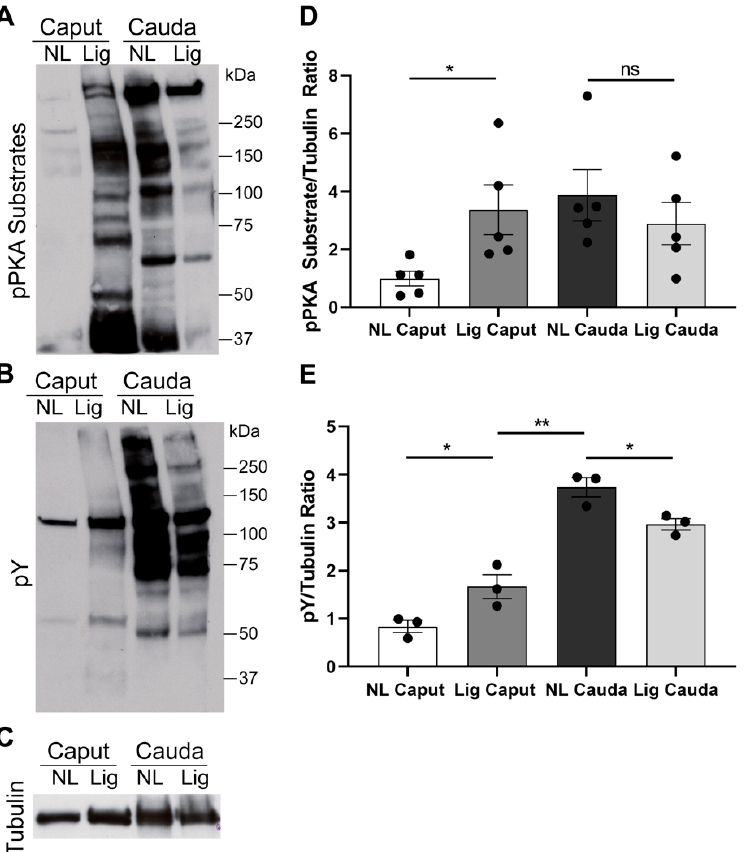
Figure 4. Changes to post-translational modifications in sperm after epididymal ligation. Sperm samples were collected from each experimental region 7-days post-ligation surgery: NL Caput, Lig Caput, NL Cauda, and Lig Cauda. Samples were capacitated for 40 min prior to protein extraction and separation by SDS-PAGE. ( A ) Western blot of phosphorylated protein kinase A substrates (pPKA substrates). n = 5. ( B ) Membranes were stripped and re-probed with an antibody against tyrosine phosphorylation (pY). n = 3. ( C ) Membranes were re-stripped and re-probed with anti β -tubulin antibody to evaluate equal loading. ( D ) Quantification of optical densitometry ratio between pPKA substrates and β -tubulin. n = 5. ( E ) Quantification of optical densitometry ratio between pY and β -tubulin. n = 3. Statistical significance comparing NL Caput vs. Lig Caput, Lig Caput vs. NL Cauda, and NL Cauda vs. Lig Cauda using an unpaired t -test in all graphs indicated; ns p > 0.05, * p < 0.05, ** p <